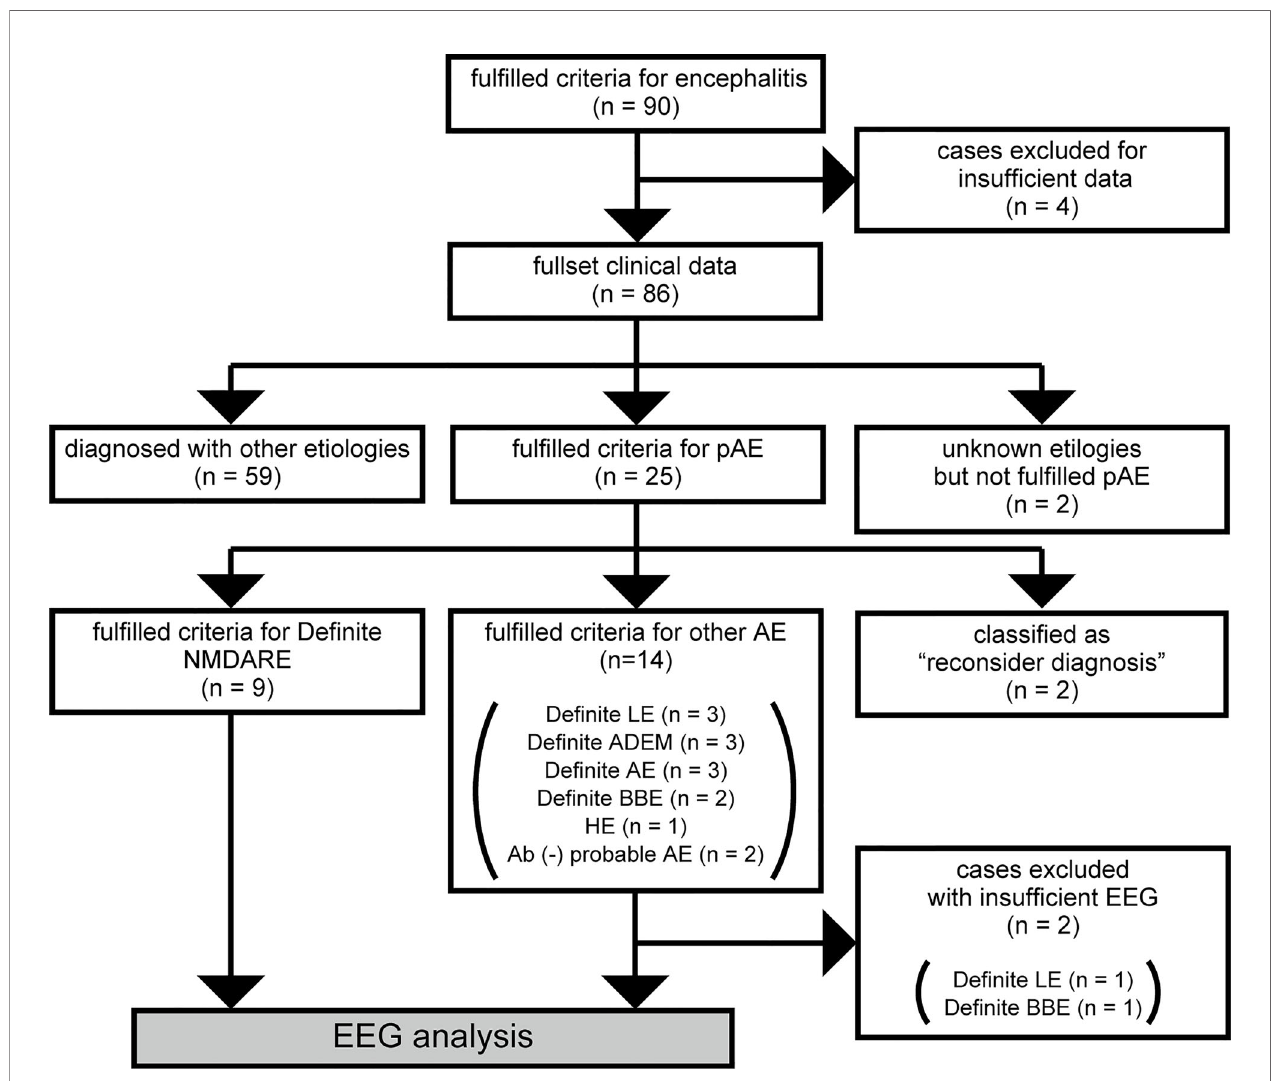
FIGURE 1 | Flowchart of patient selection and classi fi cation. Out of 90 cases that ful fi lled diagnostic criteria for acute encephalitis, four were excluded because of insuf fi cient clinical data. Out of the other 86 cases, 59 were diagnosed with encephalitis of etiologies other than autoimmunity such as infection, vasculitis, or connective tissue disorder. We could not determine an etiology of encephalitis for two cases. Twenty- fi ve cases ful fi lled criteria for pAE, which were classi fi ed using the Graus diagnostic algorithm for AE (4): 9 cases diagnosed with de fi nite NMDARE, 14 cases diagnosed with other AE, and 2 cases classi fi ed as “ reconsider diagnosis. ” Two out of the 14 cases with other AE were excluded from the following EEG analysis because of insuf fi cient EEG data. Eventually, we analyzed EEGs from 21 cases, including 9 cases with NMDARE and 12 cases with other AEs. ADEM, acute disseminated encephalomyelitis; AE, autoimmune encephalitis; BBE, Bickerstaff ’ s brainstem encephalitis; EEG, electroencephalogram; HE, Hashimoto ’ s encephalopathy; LE, limbic encephalitis; NMDARE, anti-N-methyl-d-aspartate receptor encephalitis; pAE, possible autoimmune